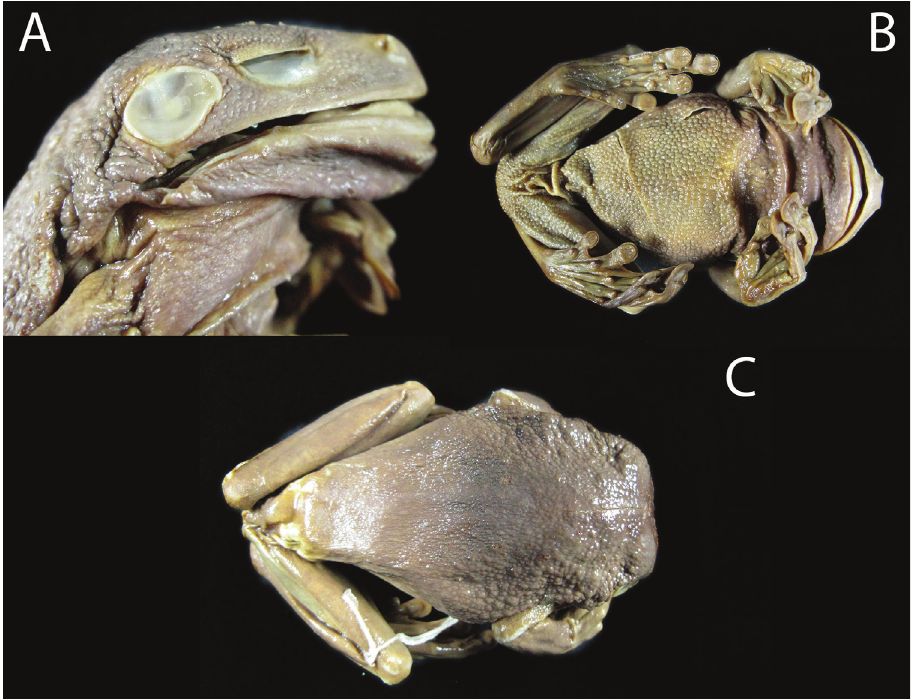
Figure 13. Holotype of Hyla macrotis Anderson 1945, NHRM 1958. A lateral view of the head B ventral view C dorsal view. The holotype is an adult female, SVL = 120 mm (Anderson 1945). Photographs by Bo